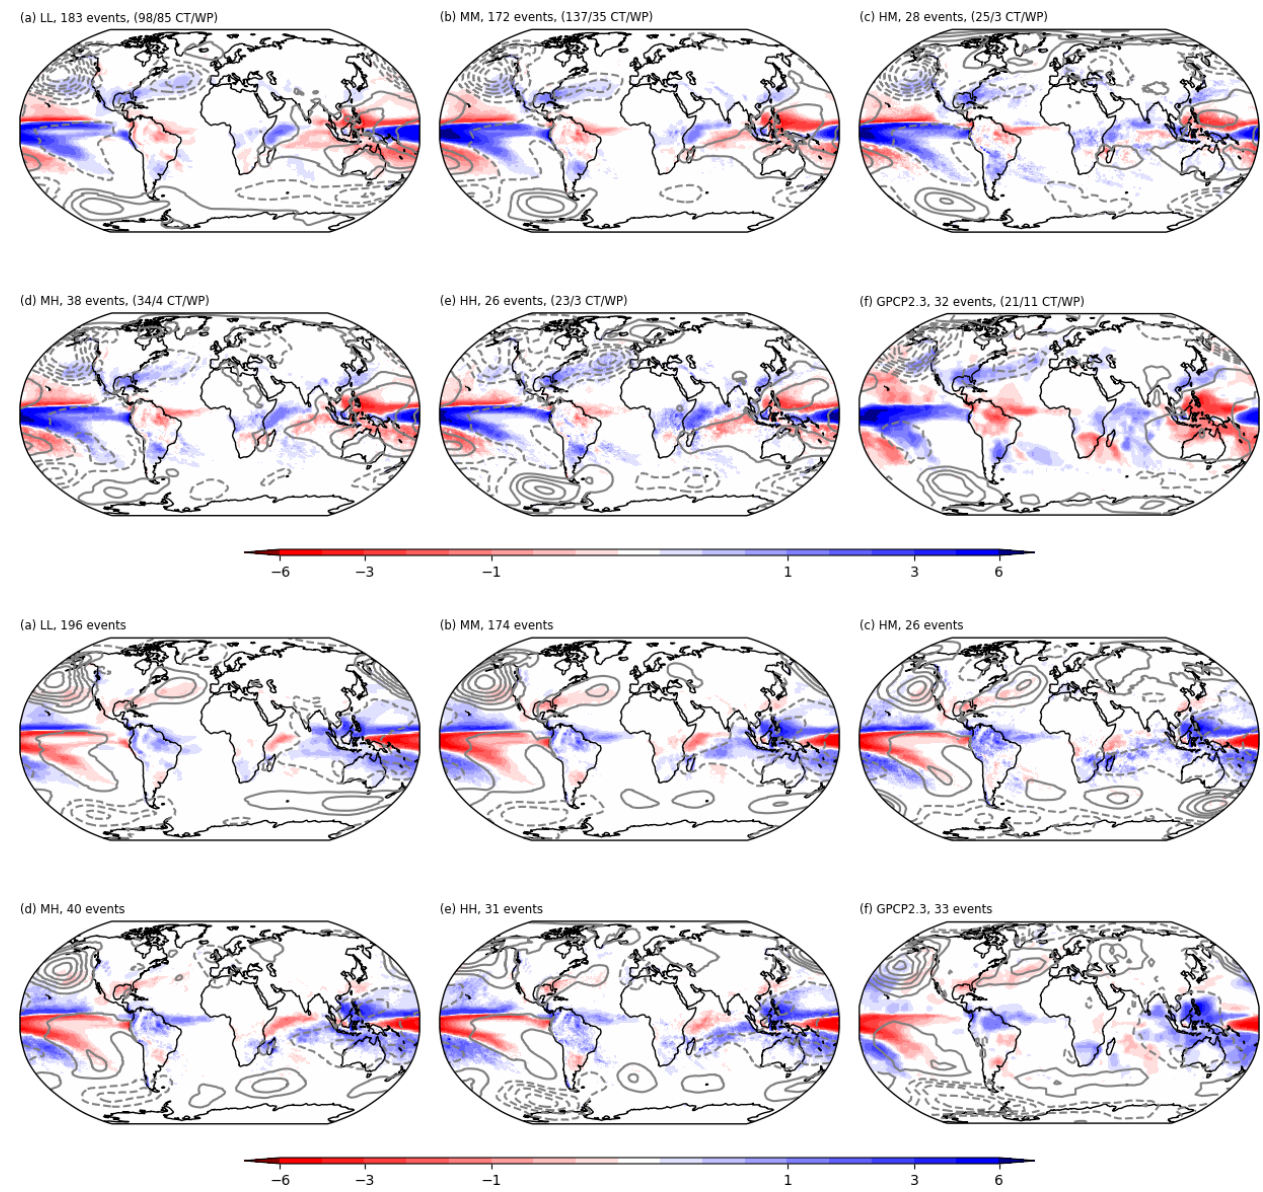
Figure 21. As Fig. 18 but for DJF composites of mean precipitation (top) El Niño and (bottom) La Niña from models and GPCP2.3 precipitation, with mean sea level pressure anomalies as contours. The number of events sampled is shown in the title, along with the proportion of El Niño events classified as CT and WP. Events are defined as years when the NINO3.4 DJF SST anomaly exceeds